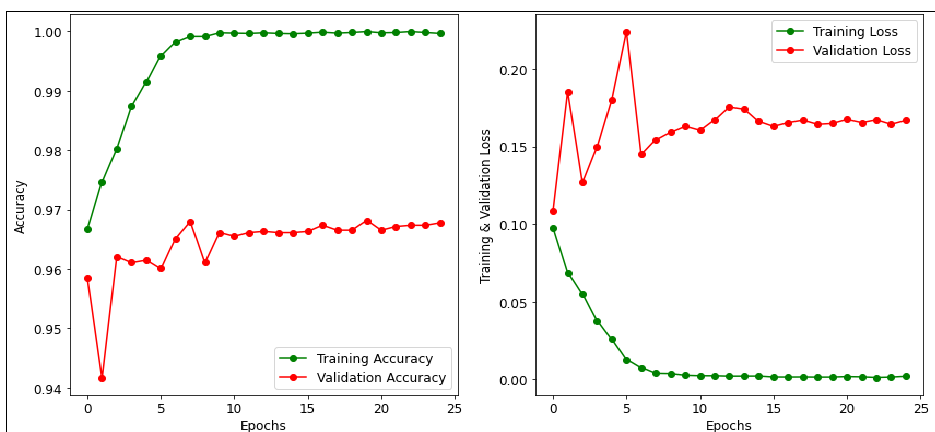
Figure 12. Accuracy and Loss of ResNet50 model.